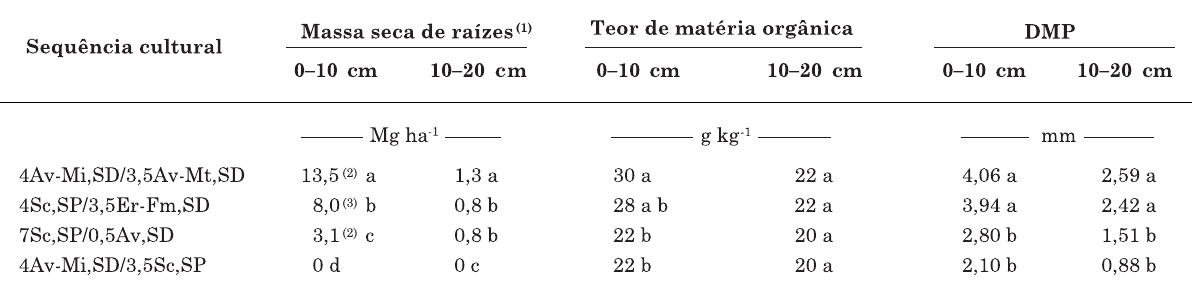
Na figura 1 são apresentados os resultados do diâmetro médio ponderado (DMP) dos agregados do solo nas suas camadas de 0 a 0,10 m para o solo não mobilizado associado aos testes de erosão T1 e T2 e de 0 a 0,15 m para o solo sucessivamente mobilizado com grade leve associado aos testes de erosão T3 a